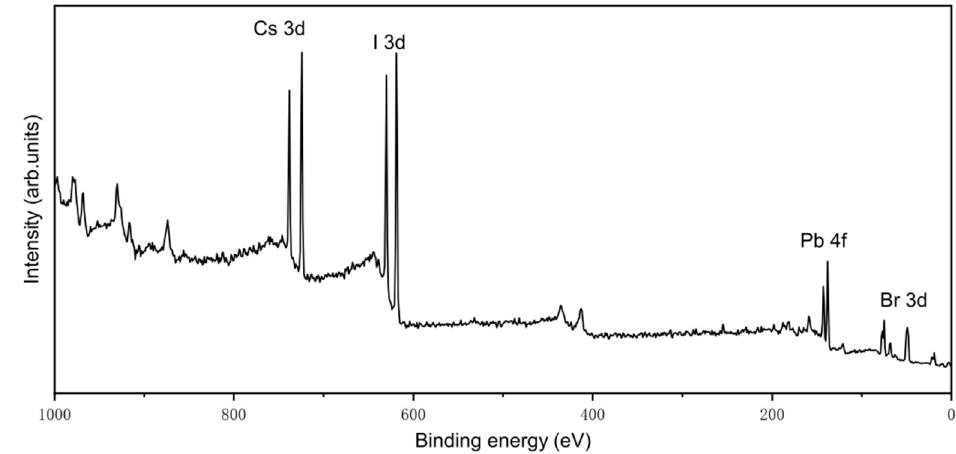
Figure A1. The XPS survey spectrum of an as-prepared CsPbI 2 Br film.